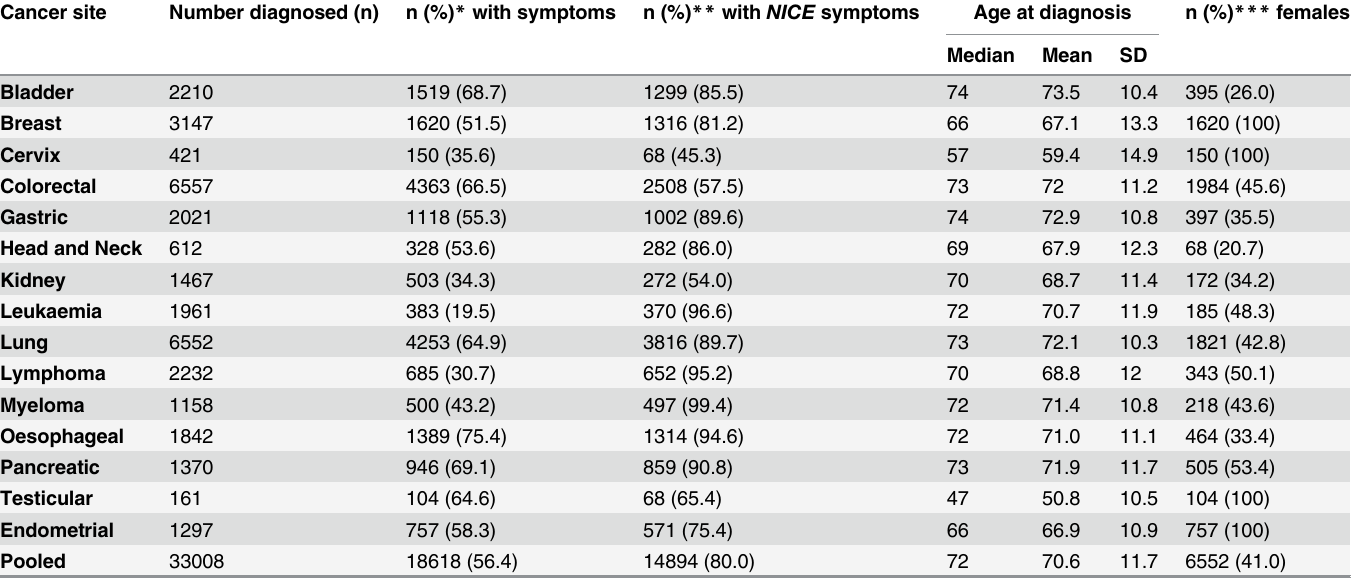
Table 1. Demographic characteristics of the patient population in the